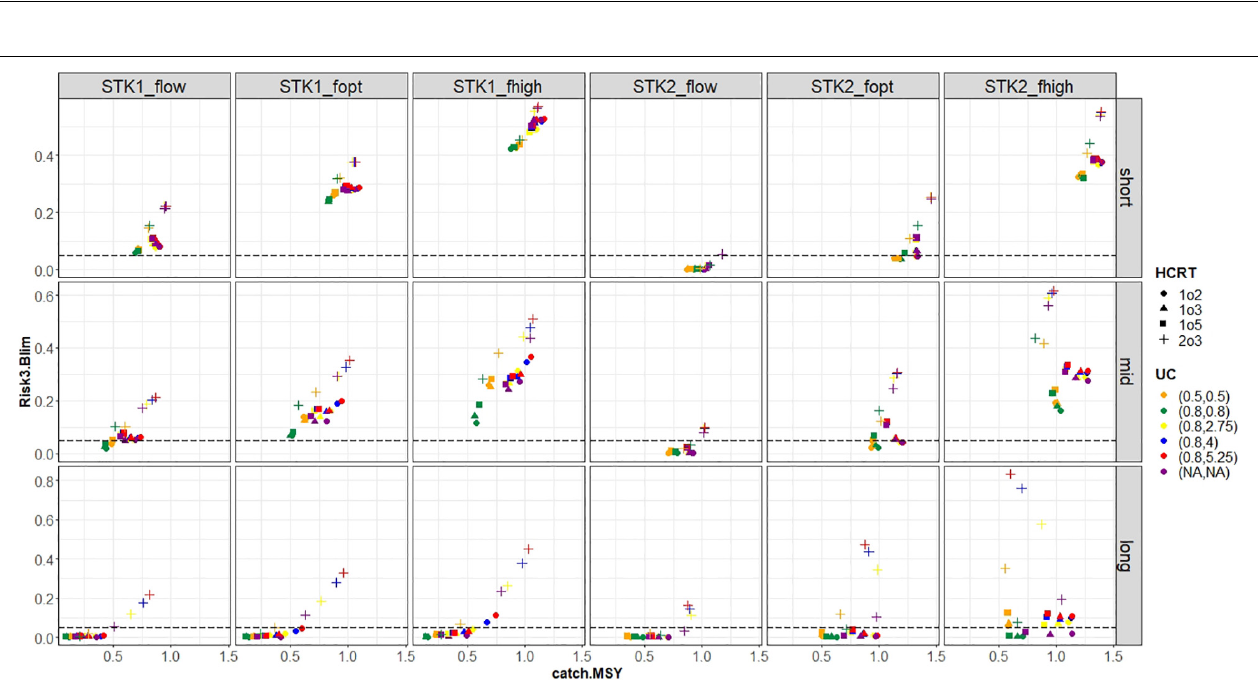
FIGURE 8 | Biological risks (Risk3.Blim: maximum probability of falling below B lim ) versus the relative yields (catches/MSY) (x-axis) by rule type (symbols) and uncertainty cap lower and upper limits (colours). The columns correspond to the different OMs (as combination of the stock-type and historical exploitation) and the rows to the temporal scales: the short-term (first 5 projection years), medium-term (next 5 projection years) and the long-term (last 10 projection years). Dashed line corresponds to the 0.05 risk. See Table 1 for definitions of abbreviations. Interactive version of the figure is available online at https://aztigps.shinyapps.io/Sanchezetal2021_FMS/.